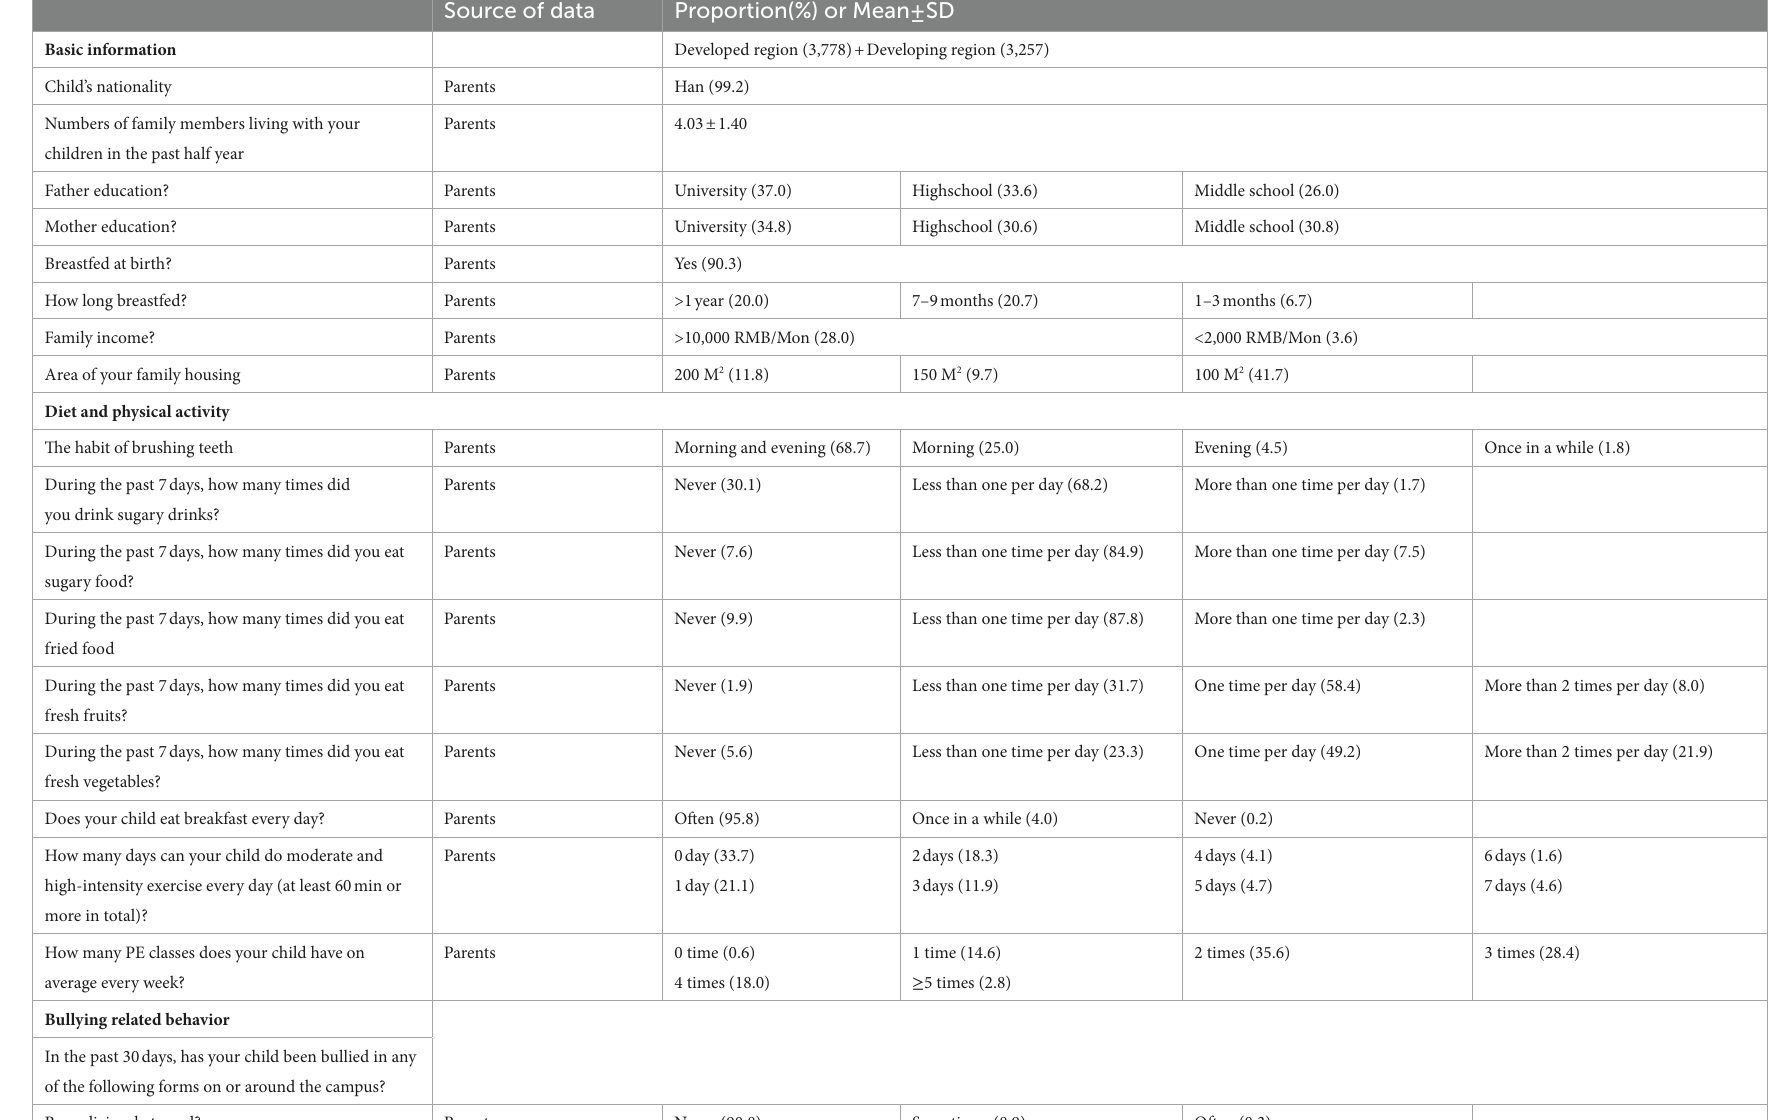
TABLE 3 Characteristics of school-based student health questionnaire surveys.